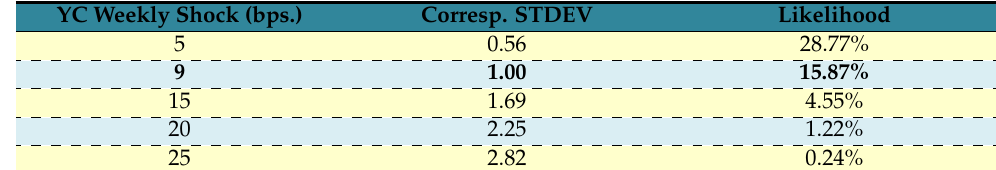
Table 8. Likelihood of principal components’ weekly yield curve shocks on 18 February 2022. YC Weekly Shock (bps.)